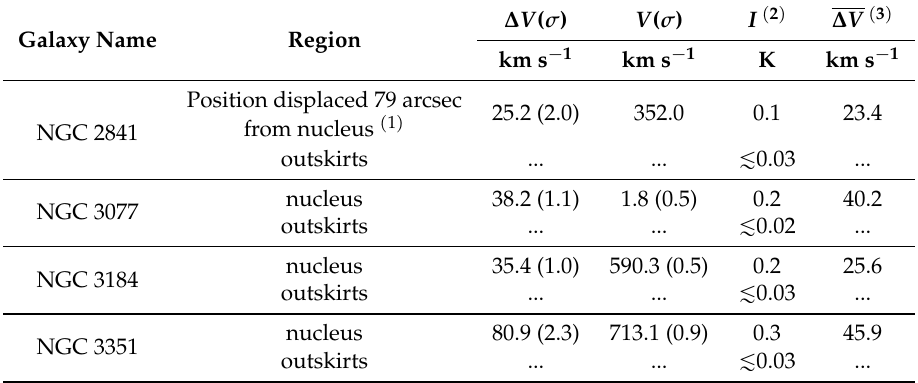
Table 2. CO(2-1) line properties derived for our galaxy sample.